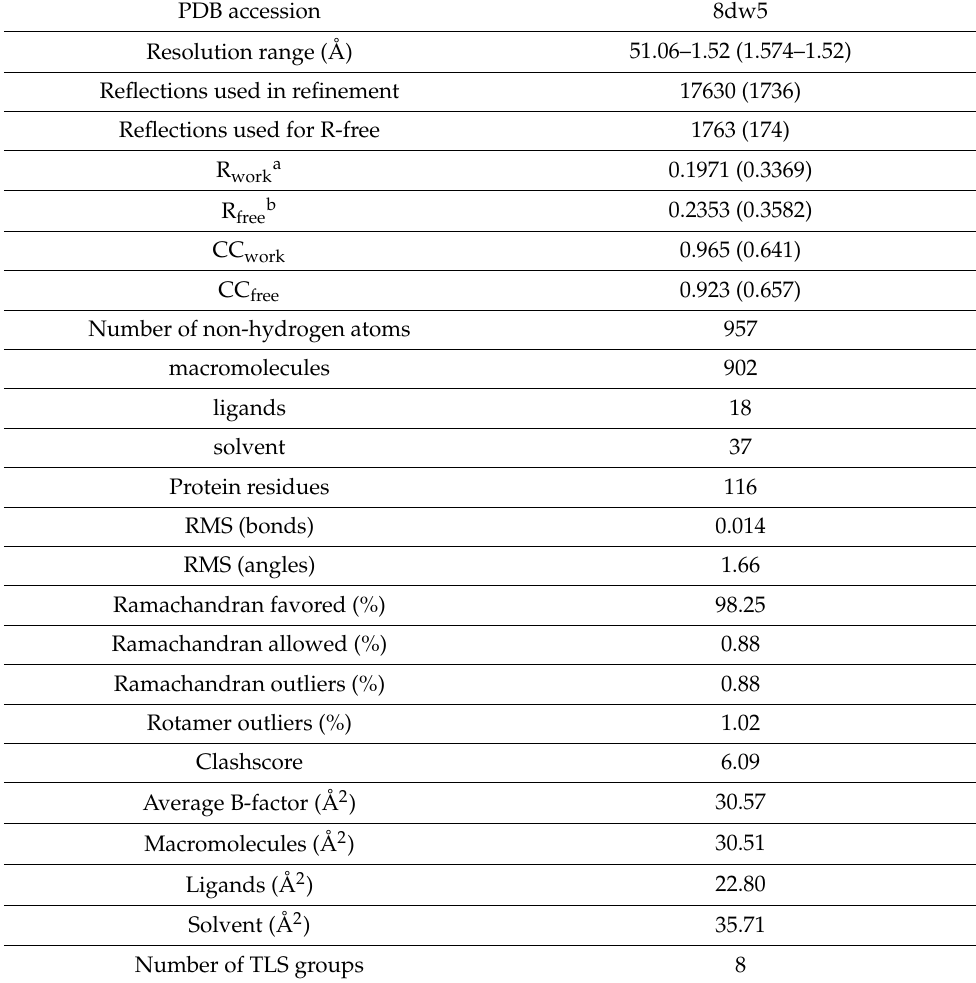
Table 3. Data refinement statistics for hTTR